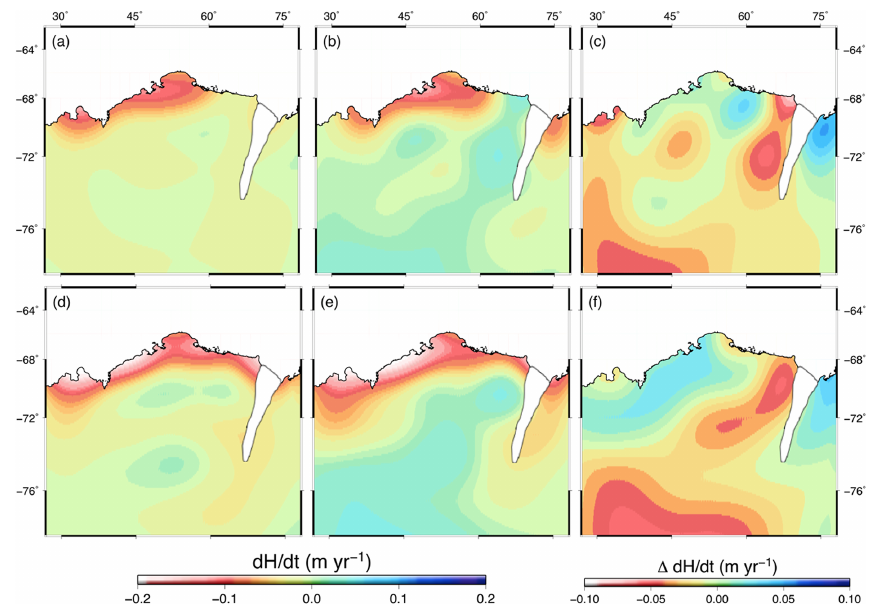
Figure 5. Comparison between the modelled ice dynamic rates obtained by employing SMB estimates from RACMO2.3 using (a) GRACE and (b) ICESat, and by employing SMB estimates from RACMO2.1 using (d) GRACE and (e) ICESat. (c) and (f) show the difference between ice dynamic rates obtained from GRACE minus ice dynamic rates obtained from ICESat for the employed SMB estimates obtained from RACMO2.3/ANT and RACMO2.1/ANT, respectively.